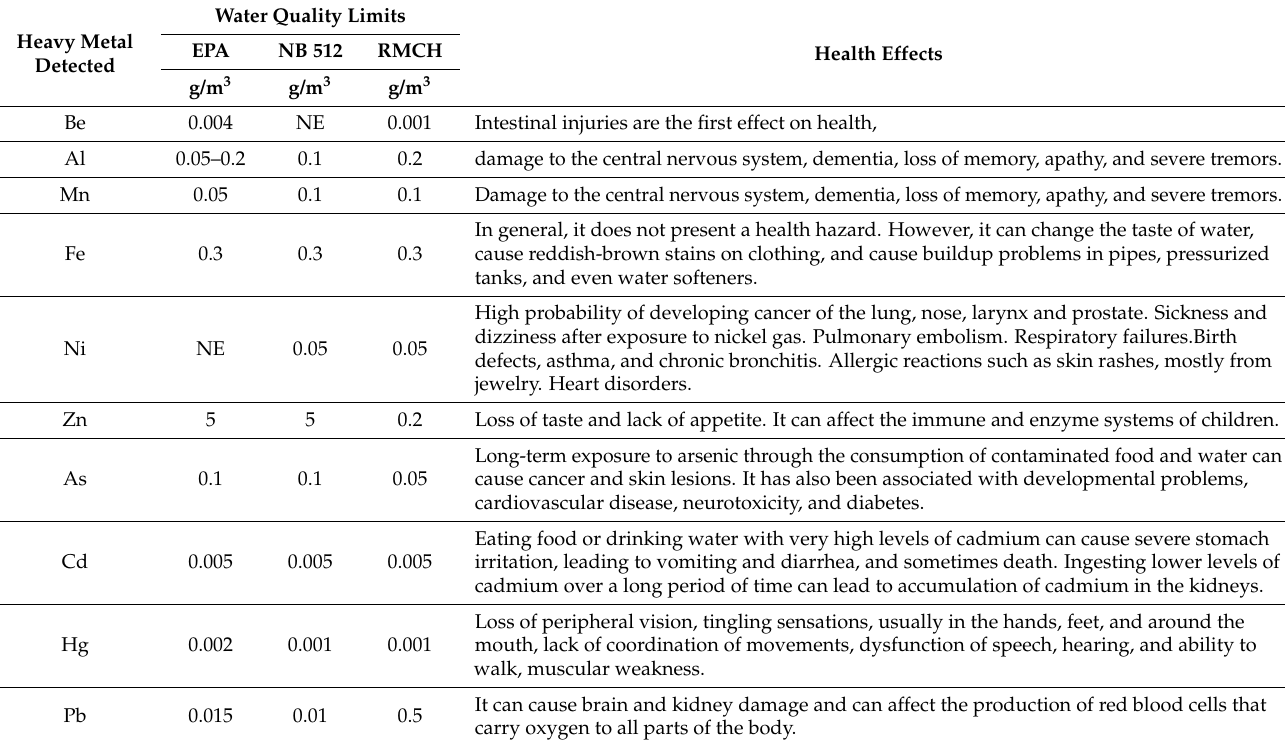
Table 1. Health effects of heavy metals.